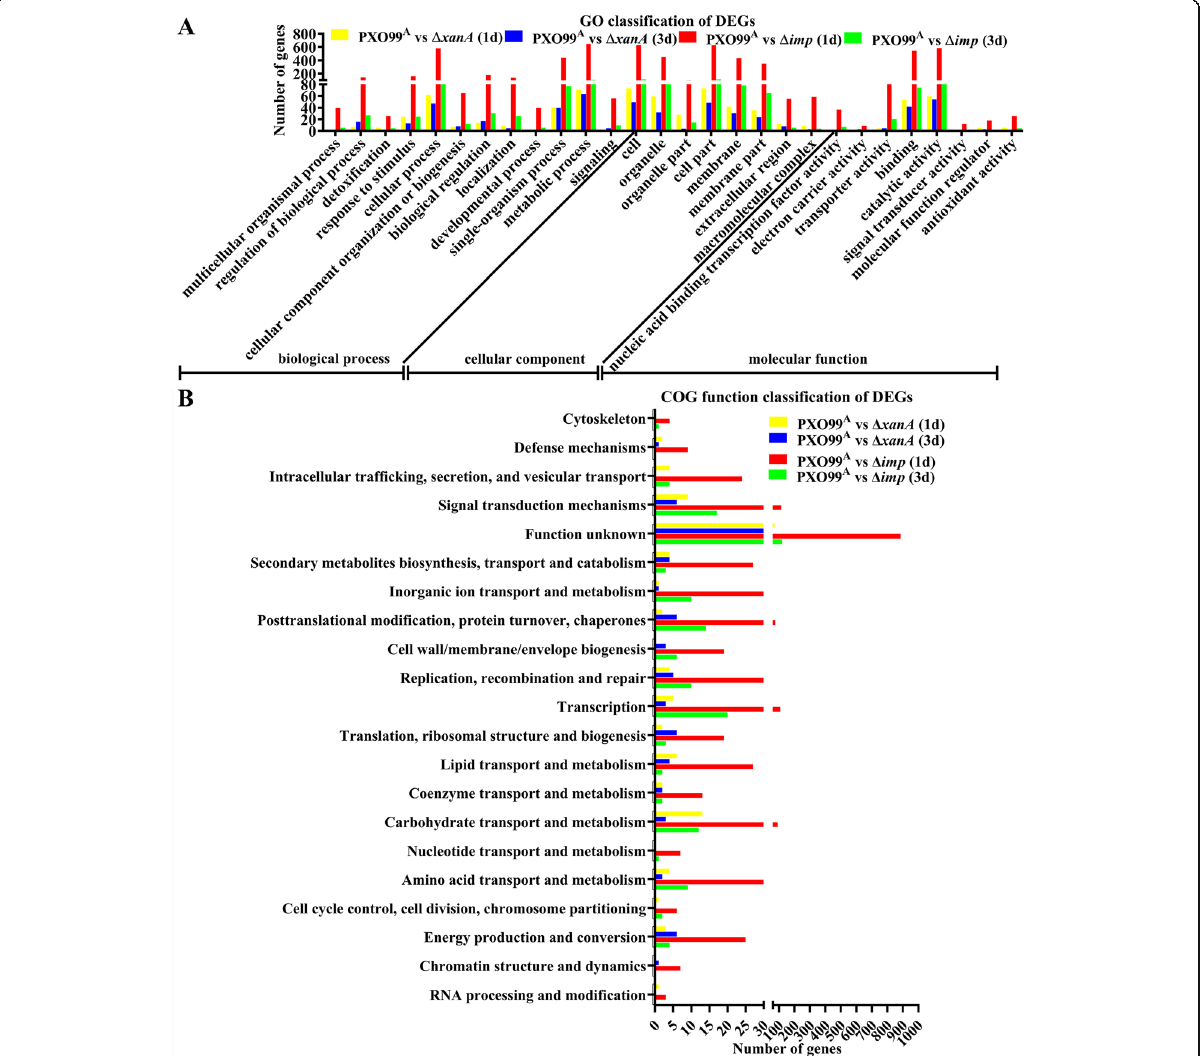
Fig. 4 Histogram presentation of Gene Ontology (GO) and Clusters of Orthologous Groups (COGs) classifications of DEGs from four pairwise comparisons: PXO99 A vs Δ xanA (1d), PXO99 A vs Δ xanA (3d), PXO99 A vs Δ imp (1d) and PXO99 A vs Δ imp (3d). A GO annotations and classifications of the DEGs. All DEGs from each pairwise comparison were classified into three main GO categories (biological process, cellular component and molecular function) and 28 dominant subcategories were presented. The x-axis shows the names of GO terms and categories. The y-axis indicates the number of DEGs in each category. B COG annotations and classifications of the DEGs. All DEGs from each pairwise comparison were assigned to 21 categories in the COG classification. The y-axis shows the description of the 21 functional categories, and the x-axis indicates the number of DEGs in each category. Any one DEG may be categorized into different GO and COG classes. Detailed information is shown